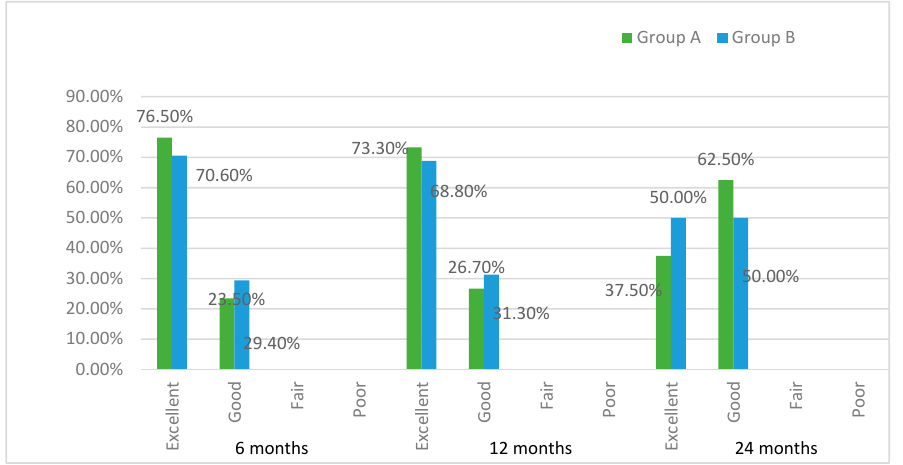
Figure 5. Patient-reported outcome measurements (PROMs).